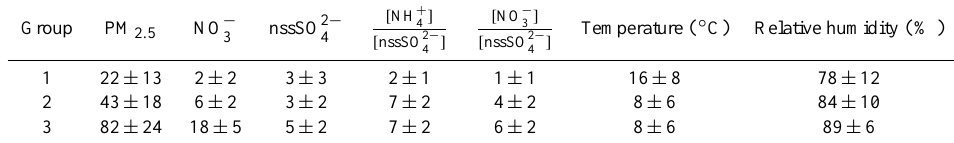
(µgm − 3 ), nssSO 2 − 3 4